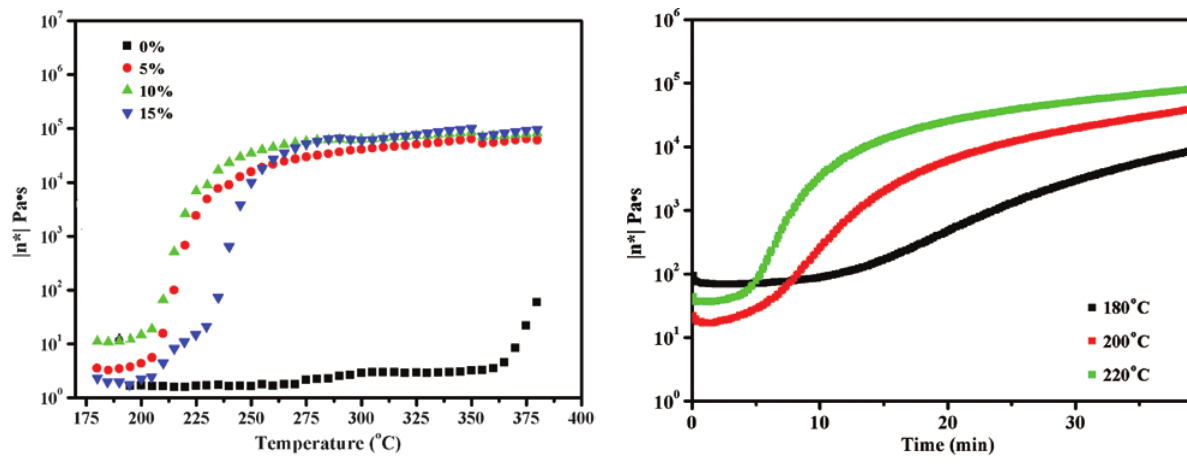
Figure 5: Time vs. viscosity curves with 10% BAPh/PEN-OH prepoly- mers at various temperatures.